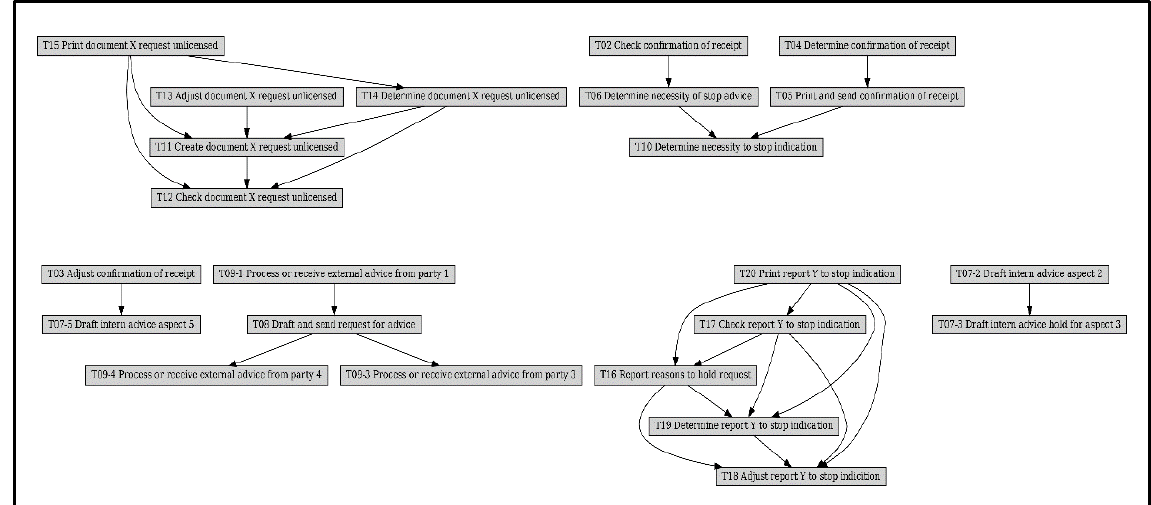
Figure 12. BN by Constraint-Based Learning from the Receipt.